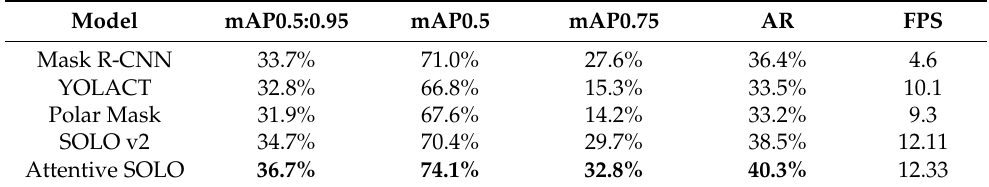
Table 5. Evaluation Results of Different Segmentation Models. The bold numbers represent the highest one of each indicator.